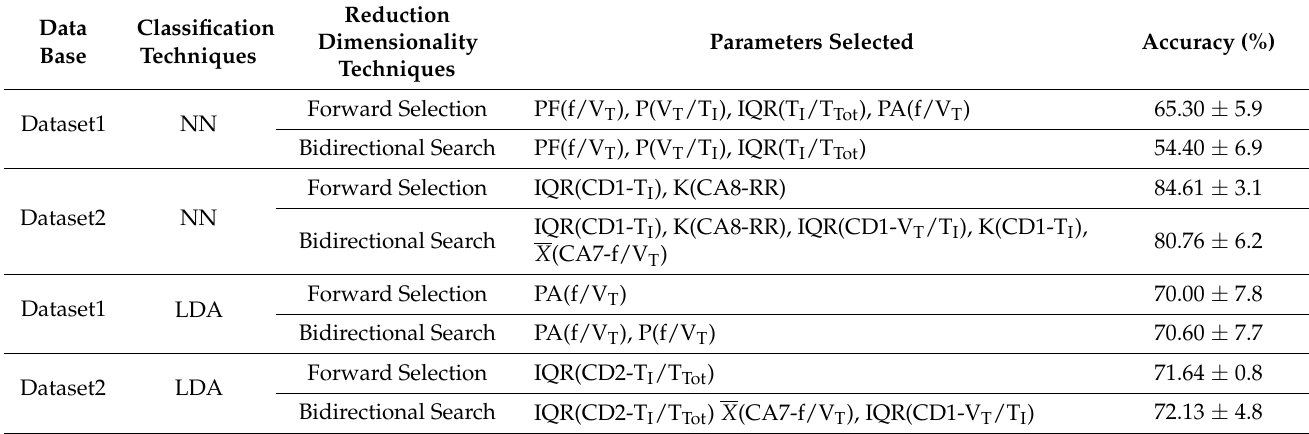
Table 3. Parameters with the highest accuracy (mean ± standard deviation), when comparing the groups of patients SG vs FG.